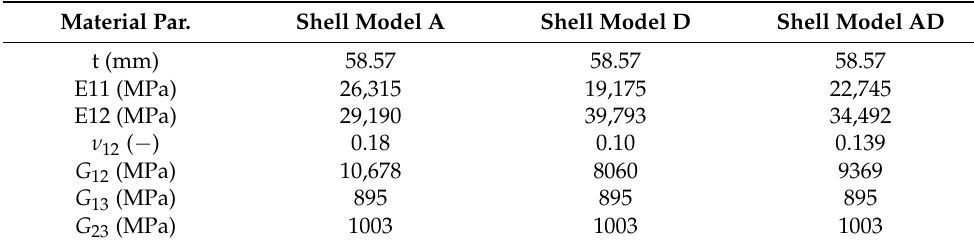
Table 4. Material properties computed after homogenization of the RVE-2 model. Three different sets of parameters using Equations (13), (14) or (15). Material